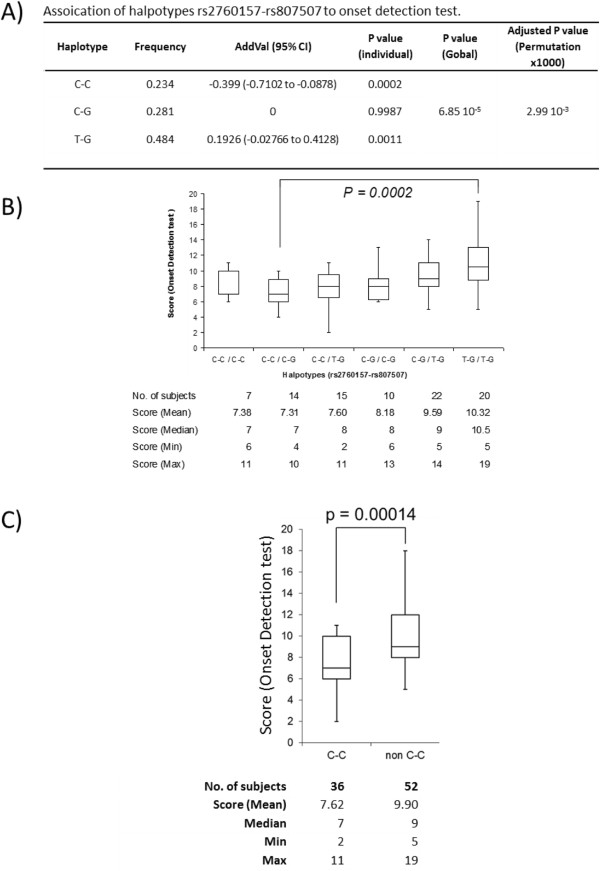
Haplotype rs2760157-rs807507 associated with onset detection score. (A) The most significant SNPs, rs2760157 and rs807507, found in single-marker quantitative analyses (onset detection) were used for haplotype analyses. The haplotypes are significantly associated with onset detection. C-C haplotype is the risk haplotype with -0.399 AddVal (95% CI = -0.7102 to -0.0878). (B) Plot of possible haplotypes found in each individual shows a decreasing trend of onset detection score for person carrying C-C haplotype. (C) The onset detection score of C-C carriers is significantly different from non-C-C carriers.